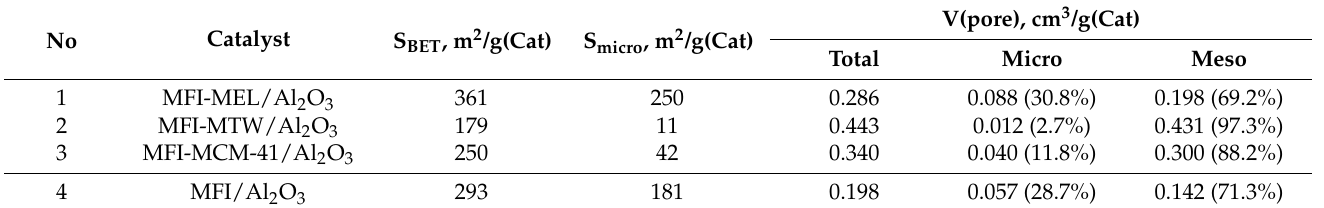
Table 1. Textural properties of the MFI-MEL/Al 2 O 3 , MFI-MTW/Al 2 O 3 , MFI-MCM-41/Al 2 O 3